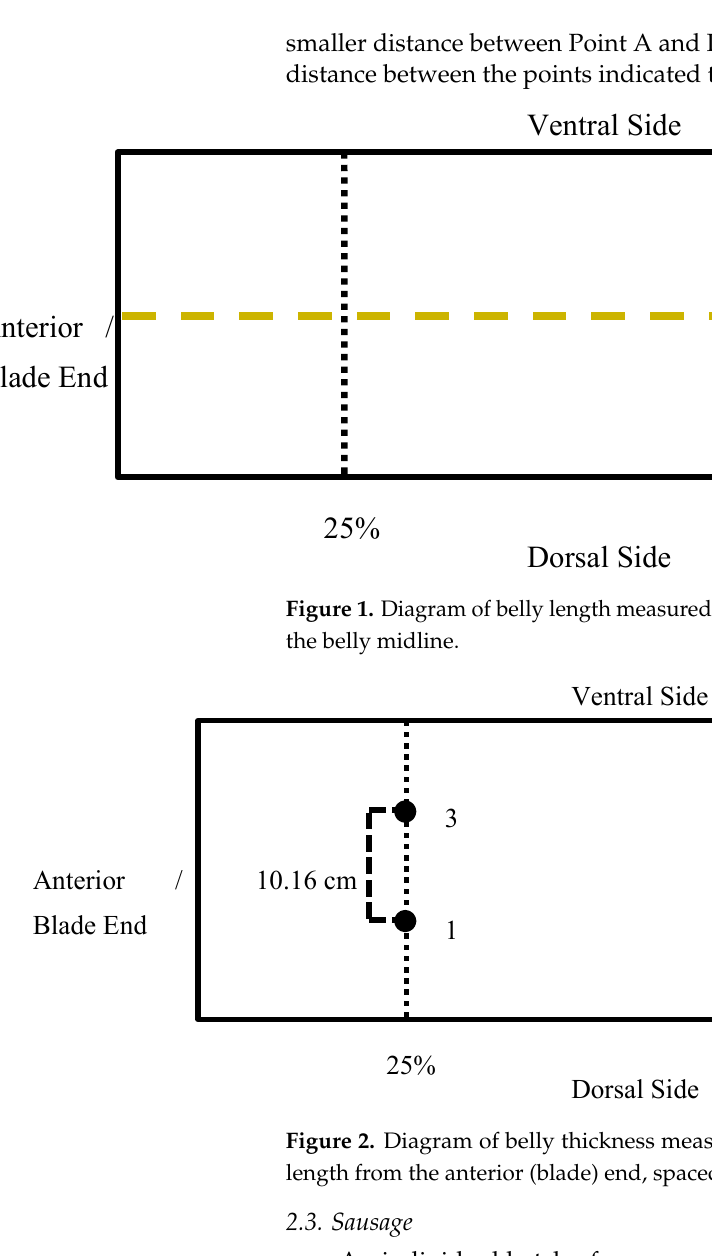
Figure 2. Diagram of belly thickness measured at four locations (1–4) at points 25 and 75% of the length from the anterior (blade) end, spaced 10.16 cm apart.